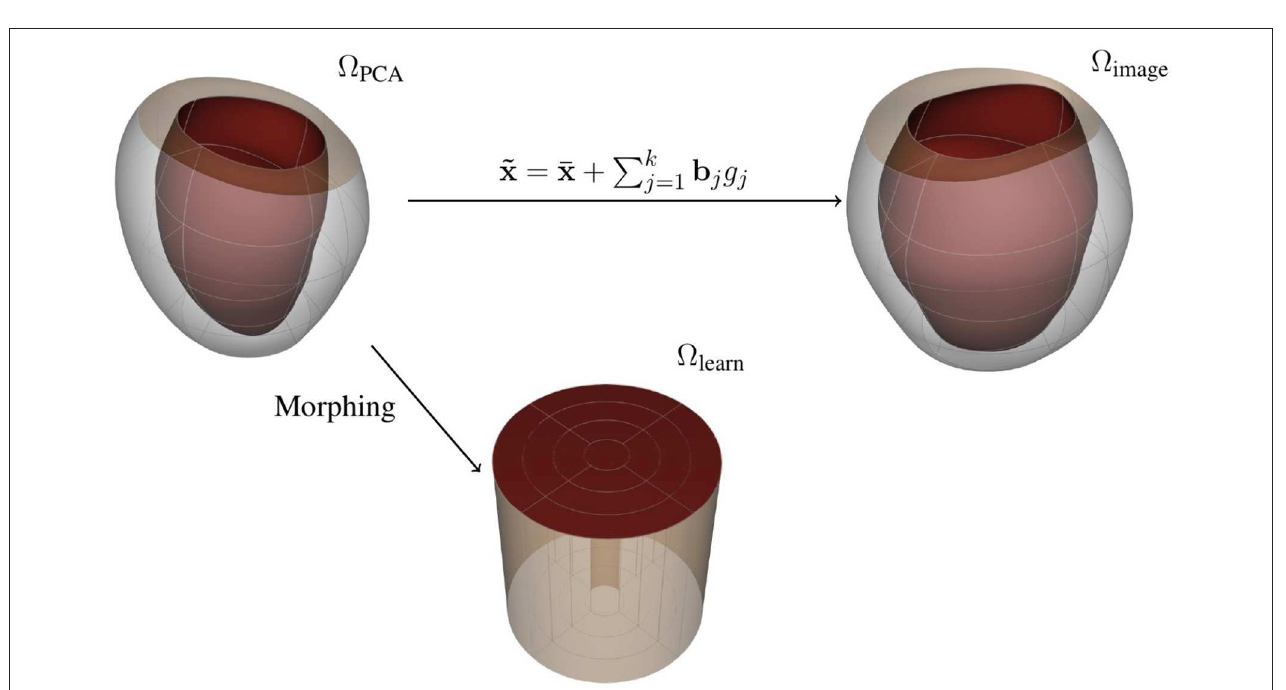
FIGURE 2 | Morphing procedure between reference (cid:127) PCA and learning (cid:127) learn . The top and bottom surface of the (cid:127) learn correspond to the endocardial surface and epicardial surface of the myocardium, respectively. The outer-radial surface corresponds to the base of the heart (beige surface). The gold spheres represent material points sampled from the geometry to help visualize the morphing process.